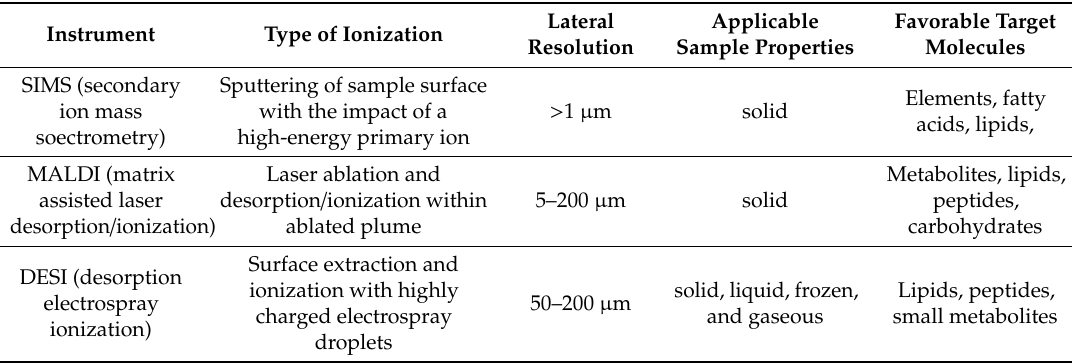
Table 1. Summary of main ionization methods of MSI.